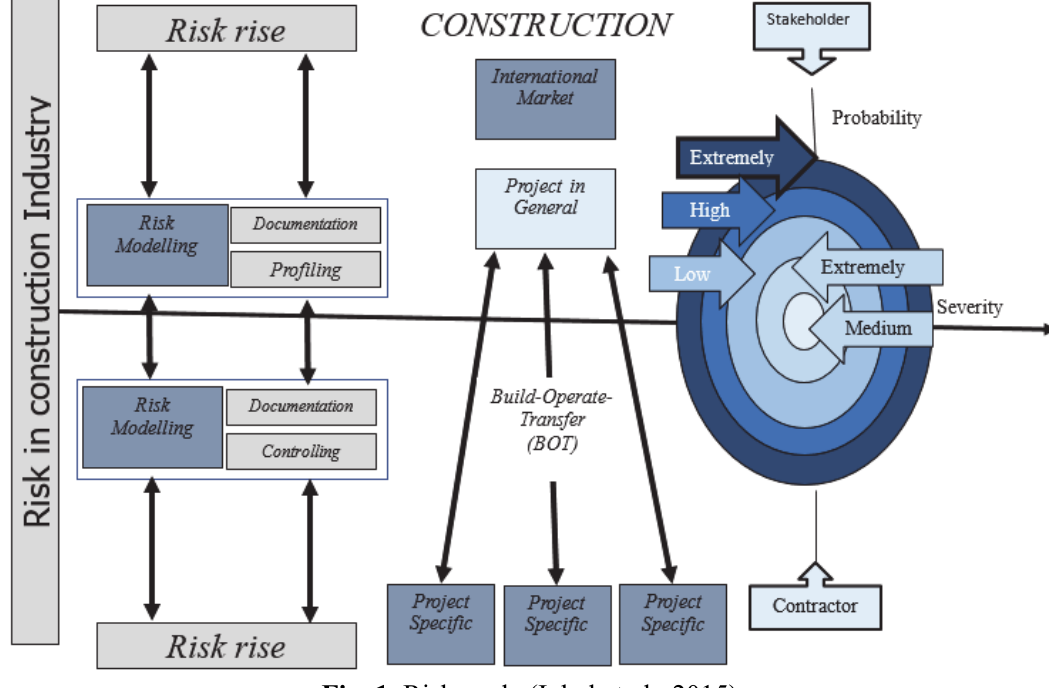
Fig. 1. Risk cycle (Iqbal et al.,